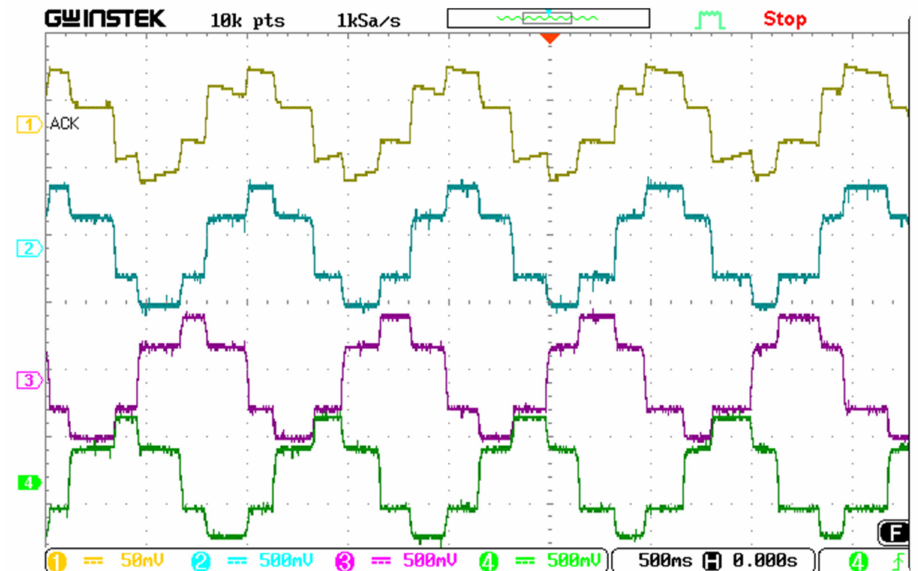
Figure 9. The inverter output currents for a three-phase resistance load, (Cha-1) phase a measure- ments with the Fluke current clamp meter, (Cha-2,3,4) phases a, b, c with LEM current transducers,